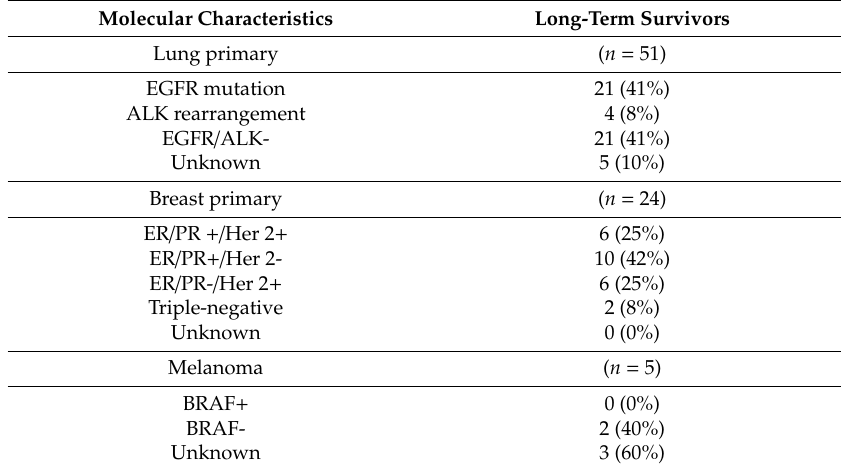
Table 2. Frequency of commonly detected driver mutations between lung, breast, and melanoma primaries for the long-term survivors.